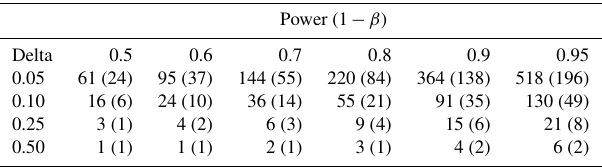
Table 2. Sample size required to estimate soil respiration with a par- ticular error (delta, left column, fraction of mean flux) for different statistical power values. Values are the mean (standard deviation) between plots. Power is the probability that the test rejects the null hypothesis when a specific alternative hypothesis is true and infor- mally connotes the degree of confidence that the measurement is within some delta value of the true